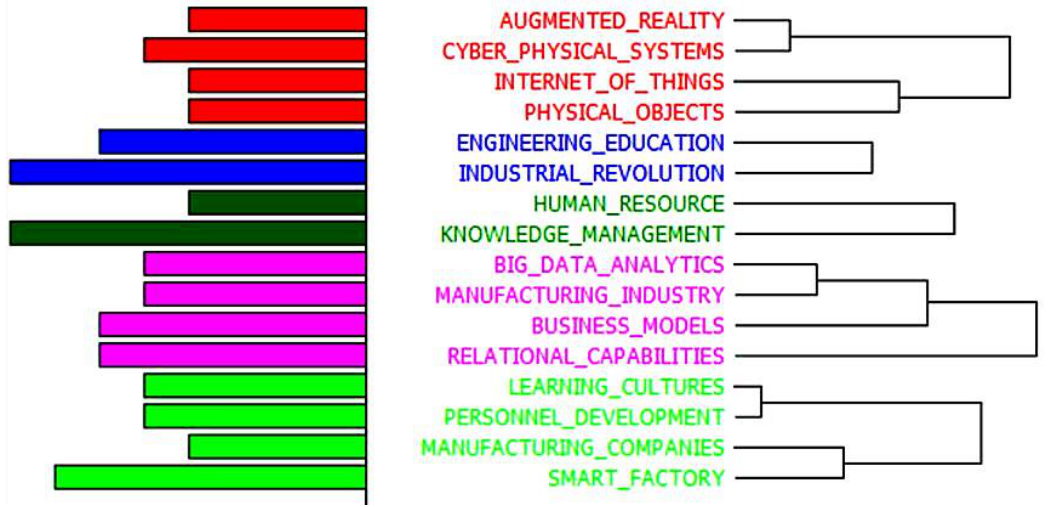
Figure 2. Cluster analysis of phrases related to future competences at a smart factory.